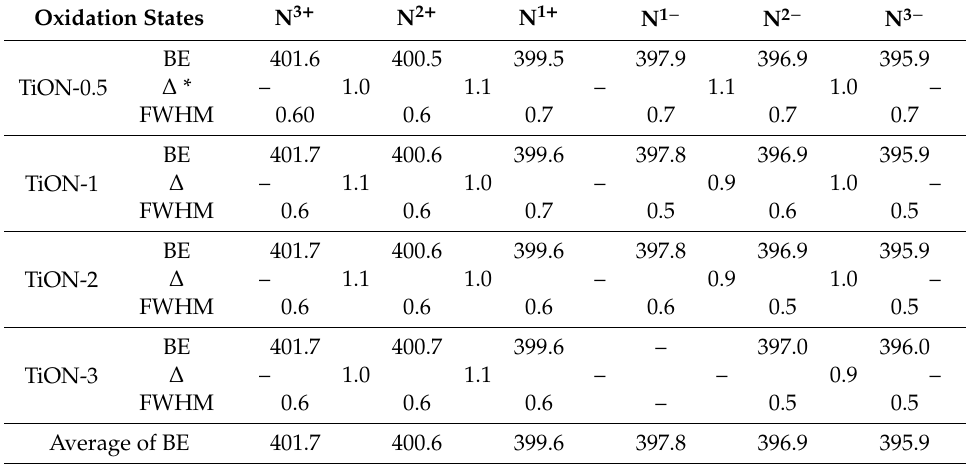
Figure 7. Original and fitted N1 s XPS spectra of titanium oxynitride films prepared using di ff erent binding energy (BE), were applied to spectral fitting. Table 1. Summary of all of the components of N 1 s in titanium oxynitride films.